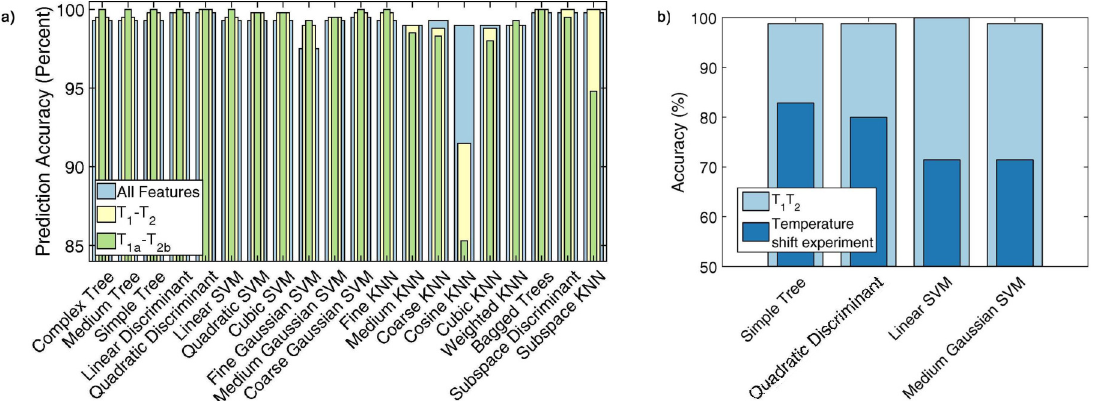
Figure 20. ( a ) Comparison of the accuracy for the predictive power of the algorithms applied to classify cooking oil samples by employing three different classification training; ( b ) accuracy of predictive power applied to soy sauce sample highlighting the effect of temperature. Figure adapted with permission from Ref. [116]. Copyright 2018